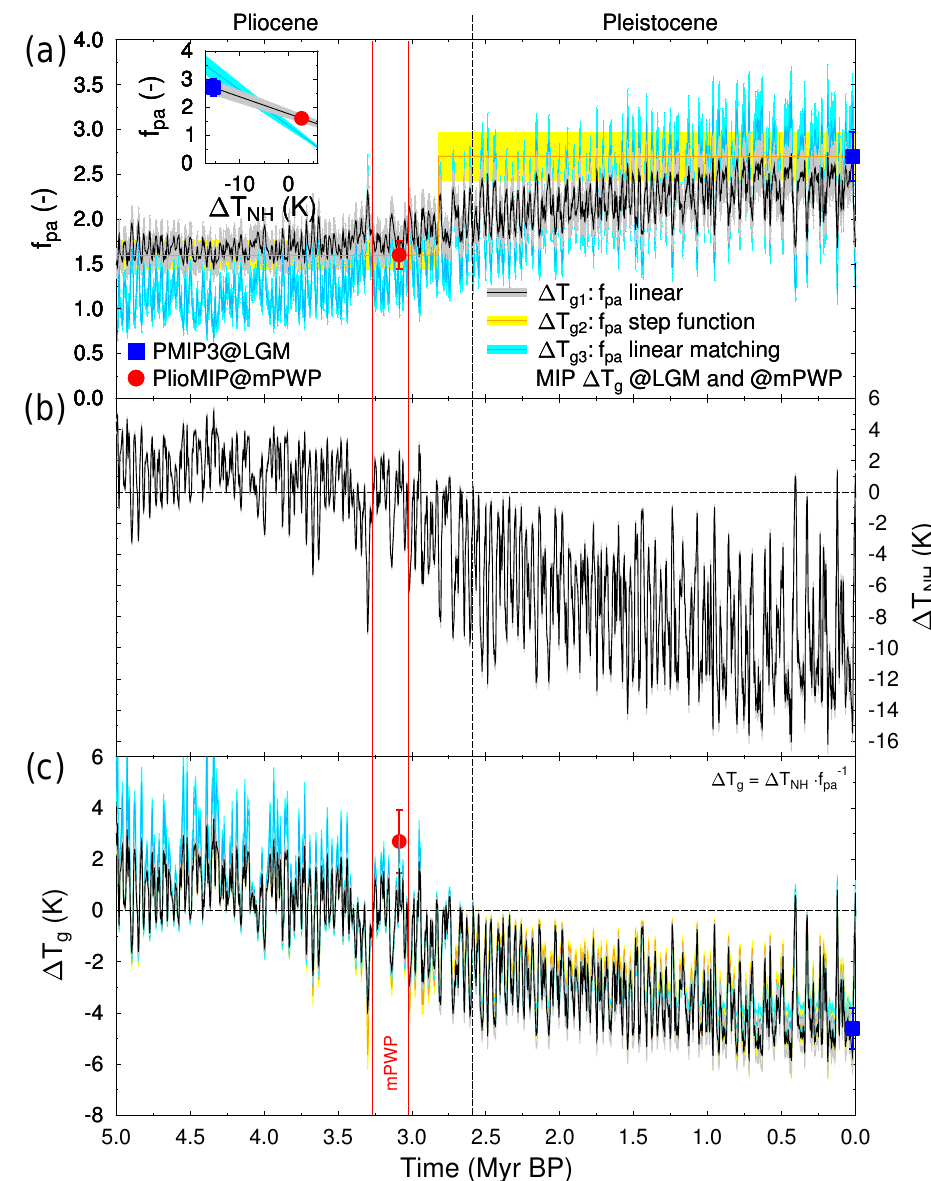
Figure 2. Calculating global surface temperature change, (cid:49)T g . Panel (a) : polar amplification factor, f pa , the ratio between Northern Hemi- sphere (NH) land temperature change, (cid:49)T NH , and global temperature change, (cid:49)T g , as a function of time based on values for LGM (blue square) and mid-Pliocene warm period (mPWP) (red circle) derived from the model intercomparison projects (MIPs) PMIP3–CMIP5 and PlioMIP (Haywood et al., 2013), respectively. In our standard application, (cid:49)T g1 (black line), f pa is calculated as a linear function depending on northern hemispheric temperature change, (cid:49)T NH (insert), inter- and extrapolated between these two PMIP3 and PlioMIP-based values. Alternatively ( (cid:49)T g2 , orange line), f pa varies as a step function with high values for the Pleistocene (periods with Northern Hemisphere land ice sheets) and low values for the Pliocene (periods mainly without NH land ice sheets) with the step between both values occurring at 2 . 82MyrBP, when our results indicate large changes in NH land ice. In (cid:49)T g3 (blue line), f pa varied freely to meet (cid:49)T g reconstructed for LGM by PMIP3 ( − 4 . 6K) and for the mPWP by PlioMIP ( + 2 . 7K). See methods for further details. Panel (b) : NH temperature change, (cid:49)T NH , as deconvolved from the benthic δ 18 O stack LR04 (Lisiecki and Raymo, 2005) by applying a 3-D ice-sheet model in an inverse mode (de Boer et al., 2014). Uncertainty in (cid:49)T NH (grey) is the 1 σ error calculated from eight different model realizations (de Boer et al., 2014). Panel (c) : global surface temperature change, (cid:49)T g , as used here based on (cid:49)T g = (cid:49)T NH · f − 1 pa . Results for (cid:49)T g based on all three approaches for f pa are given (same colour code as in subfigure a ). Symbols show (cid:49)T g ± 1 σ as derived within PlioMIP (mPWP, red circle) and PMIP3–CMIP5 (LGM, blue square). Red vertical lines mark the time period of the